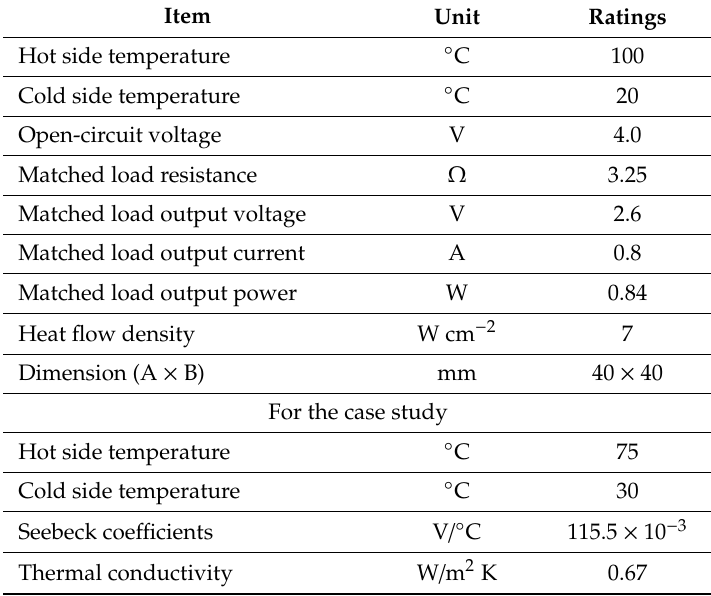
Table 4. Electrical specifications and dimensions of a TE-MOD-1W2V-40S [43]. Item Unit Ratings Hot side temperature ◦ C 100 Cold side temperature ◦ C 20 Open-circuit voltage V 4.0 Ω